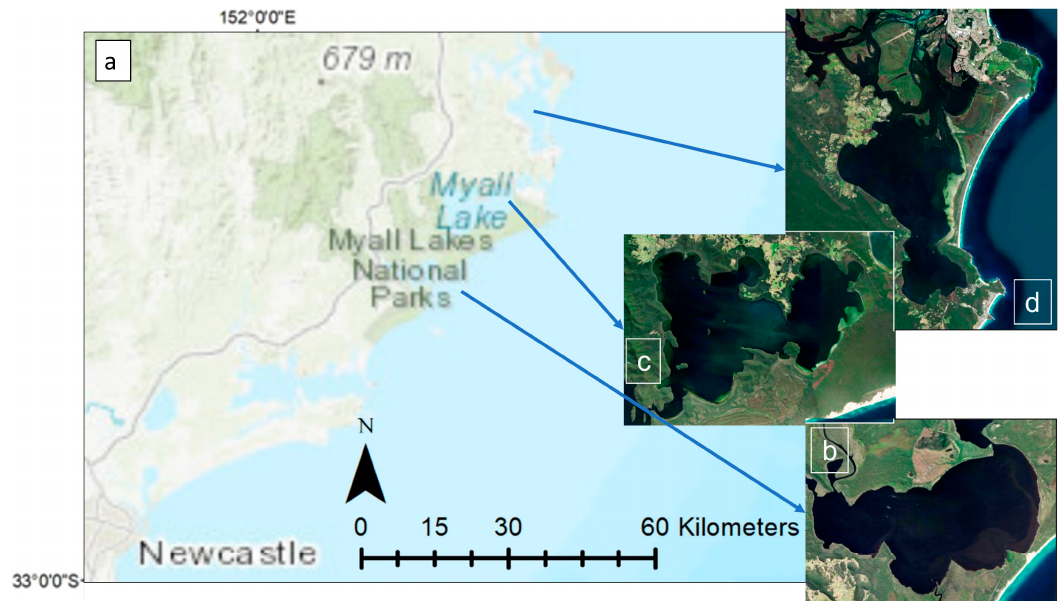
Figure 1. ( a ) Bombah Broadwater, Myall Lake, and Wallis Lake along the coast of New South Wales, north of Newcastle (Australia). ( b ) Bombah Broadwater. ( c ) Myall Lake. ( d ) Wallis Lake.